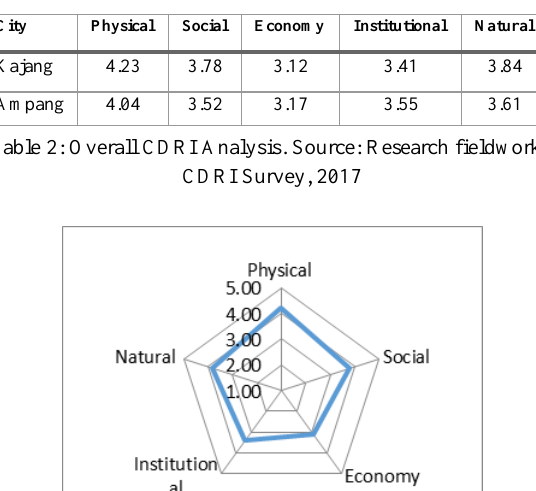
Table 4: Assessment of Social Component. Source: